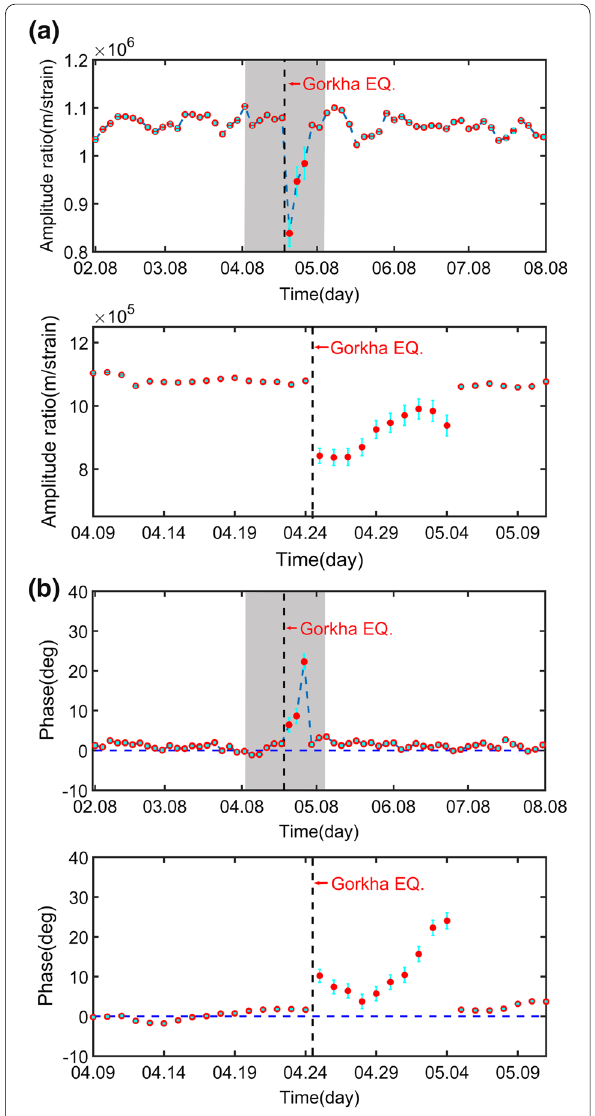
Fig. 7 Amplitude ratio ( a ) and phase response ( b ) of D22 well at M2 wave frequency change with time. Amplitude response is amplitude ratio of earth tide and water level. Dotted line shows the origin time of 2015 Gorkha earthquake (Beijing time). Blue error bars indicate the error of the tidal analysis. Bottom panels in figures a and b are the magnifications of the corresponding period of the gray background in the top panels,